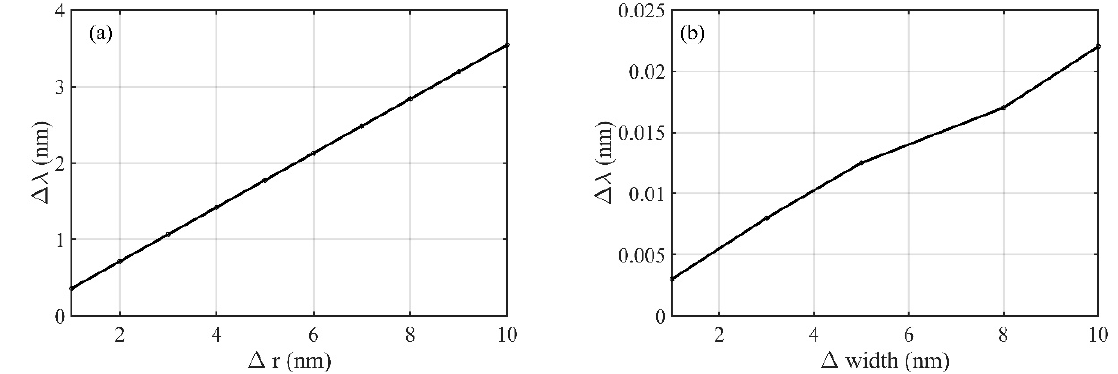
Figure 12. Resonance wavelength deviation caused by ( a ) the difference of radius ∆ r, and ( b ) the difference of waveguide width ∆ width.